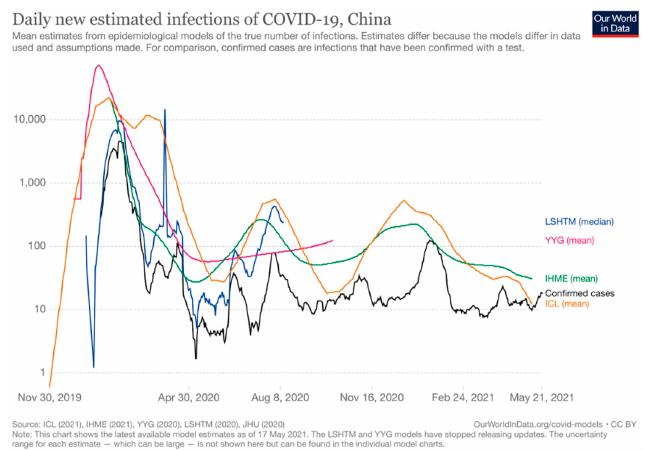
Figure 1. Daily new estimated infections of COVID-19 in China [43].